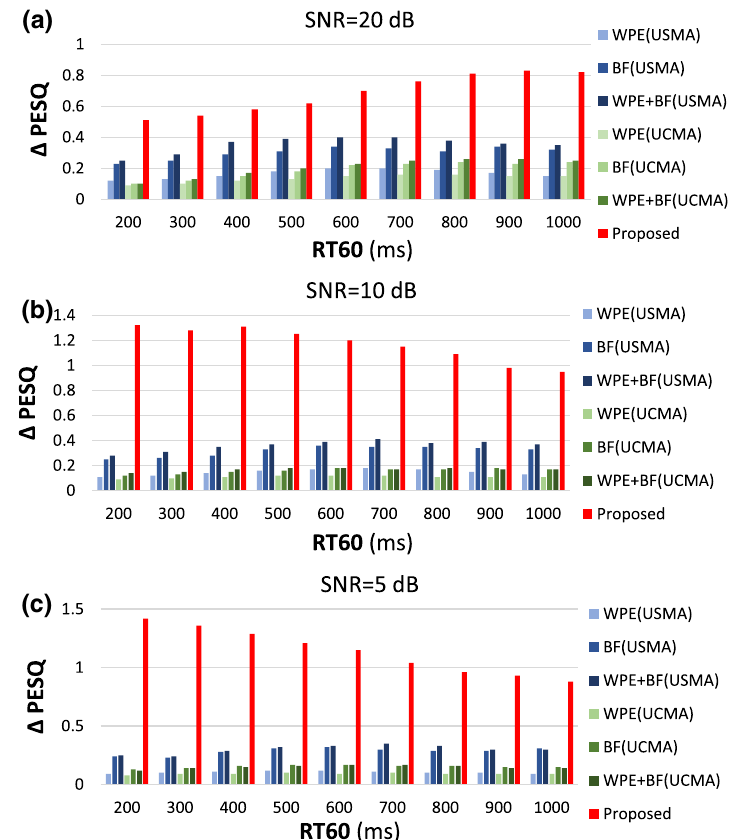
Fig. 8 (cid:31) PESQ changes in proportion to RT60 for beamforming (BF), dereverberation (WPE) and their combination (WPE BF) with the USMA and the UCMA geometries in comparison to the proposed + approach in three noise